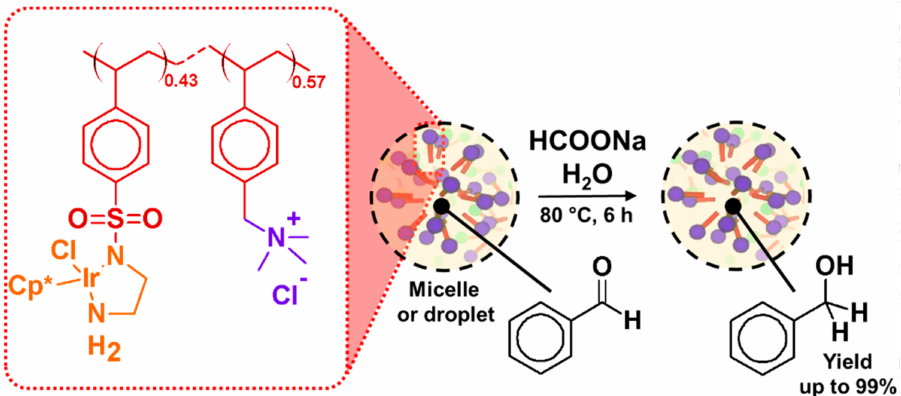
Figure 25. Catalytic hydrogenation of aldehydes using an amphiphilic polymer combined with an iridium organometallic